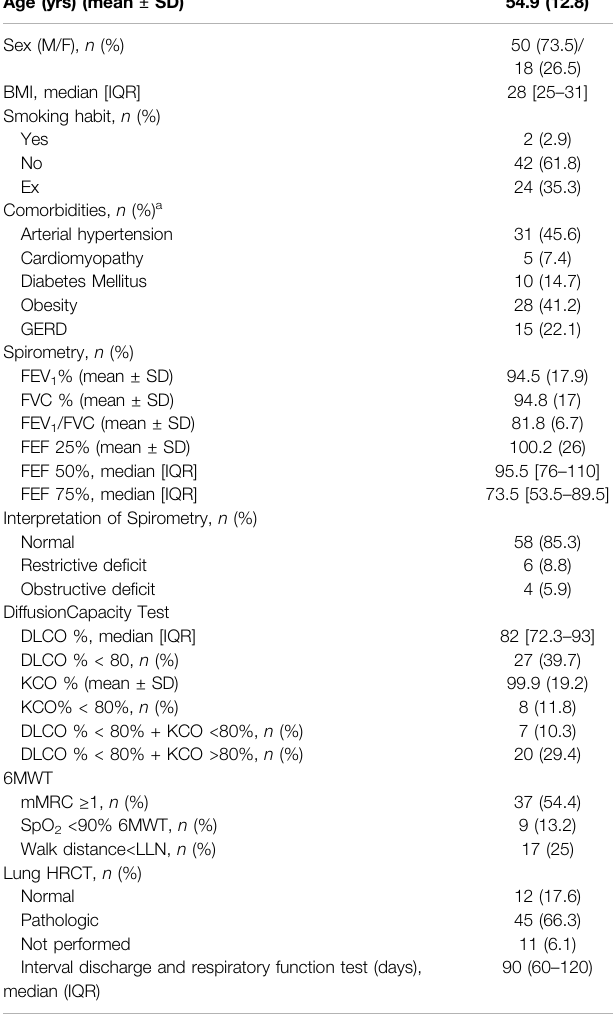
TABLE 1 | Baseline characteristics of the study population ( n (cid:1)